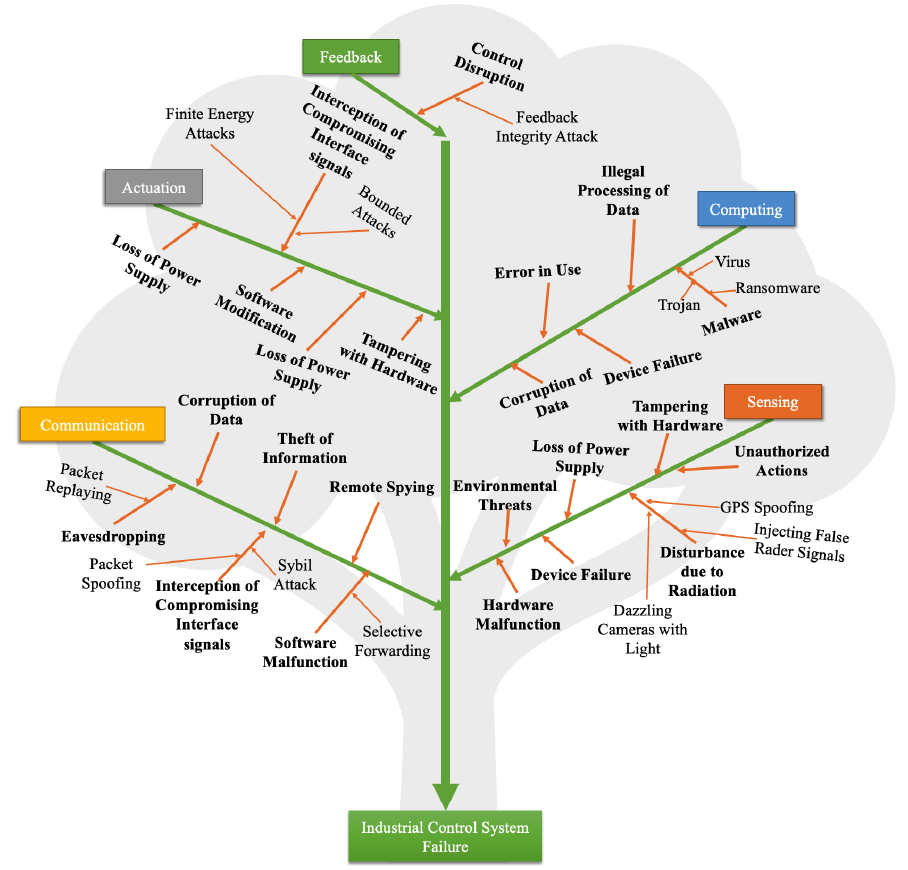
Figure 1. The Potential Threats and Attacks of